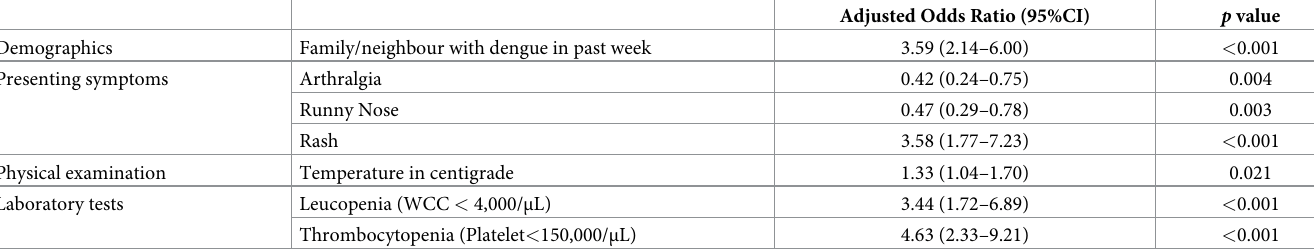
Table 4. Multiple logistic regression analysis of factors associated with dengue